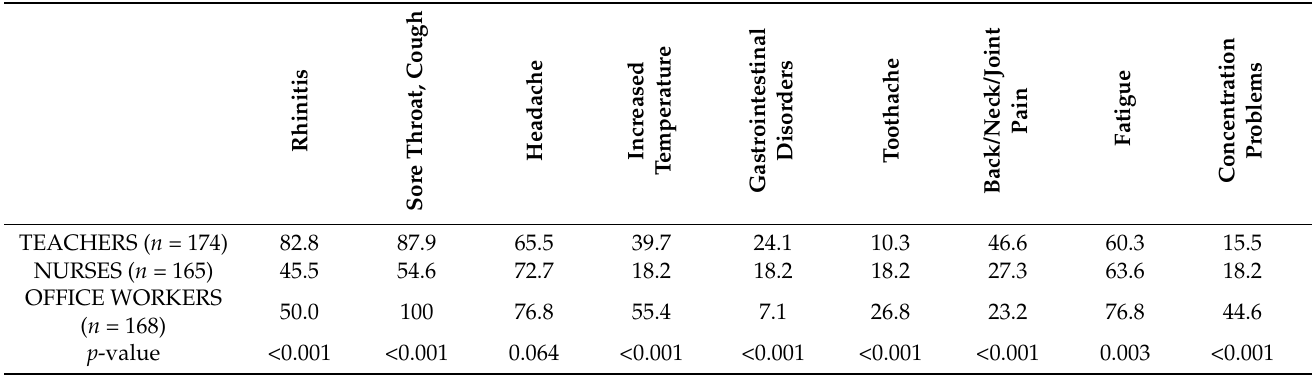
Table 3. Distribution of responses (%) and p -values for the chi-squared test concerning selected ailments that respondents worked with.